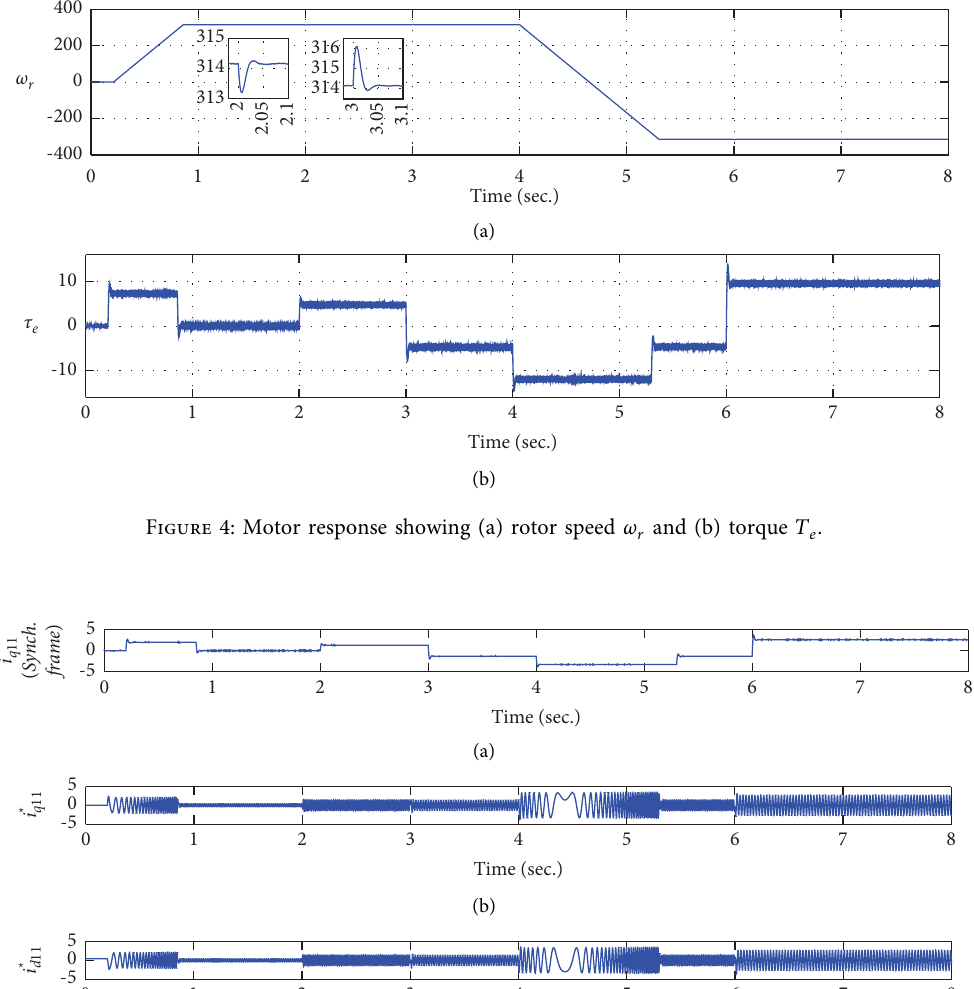
Figure 5: Motor current through inverter 1 showing reference current.